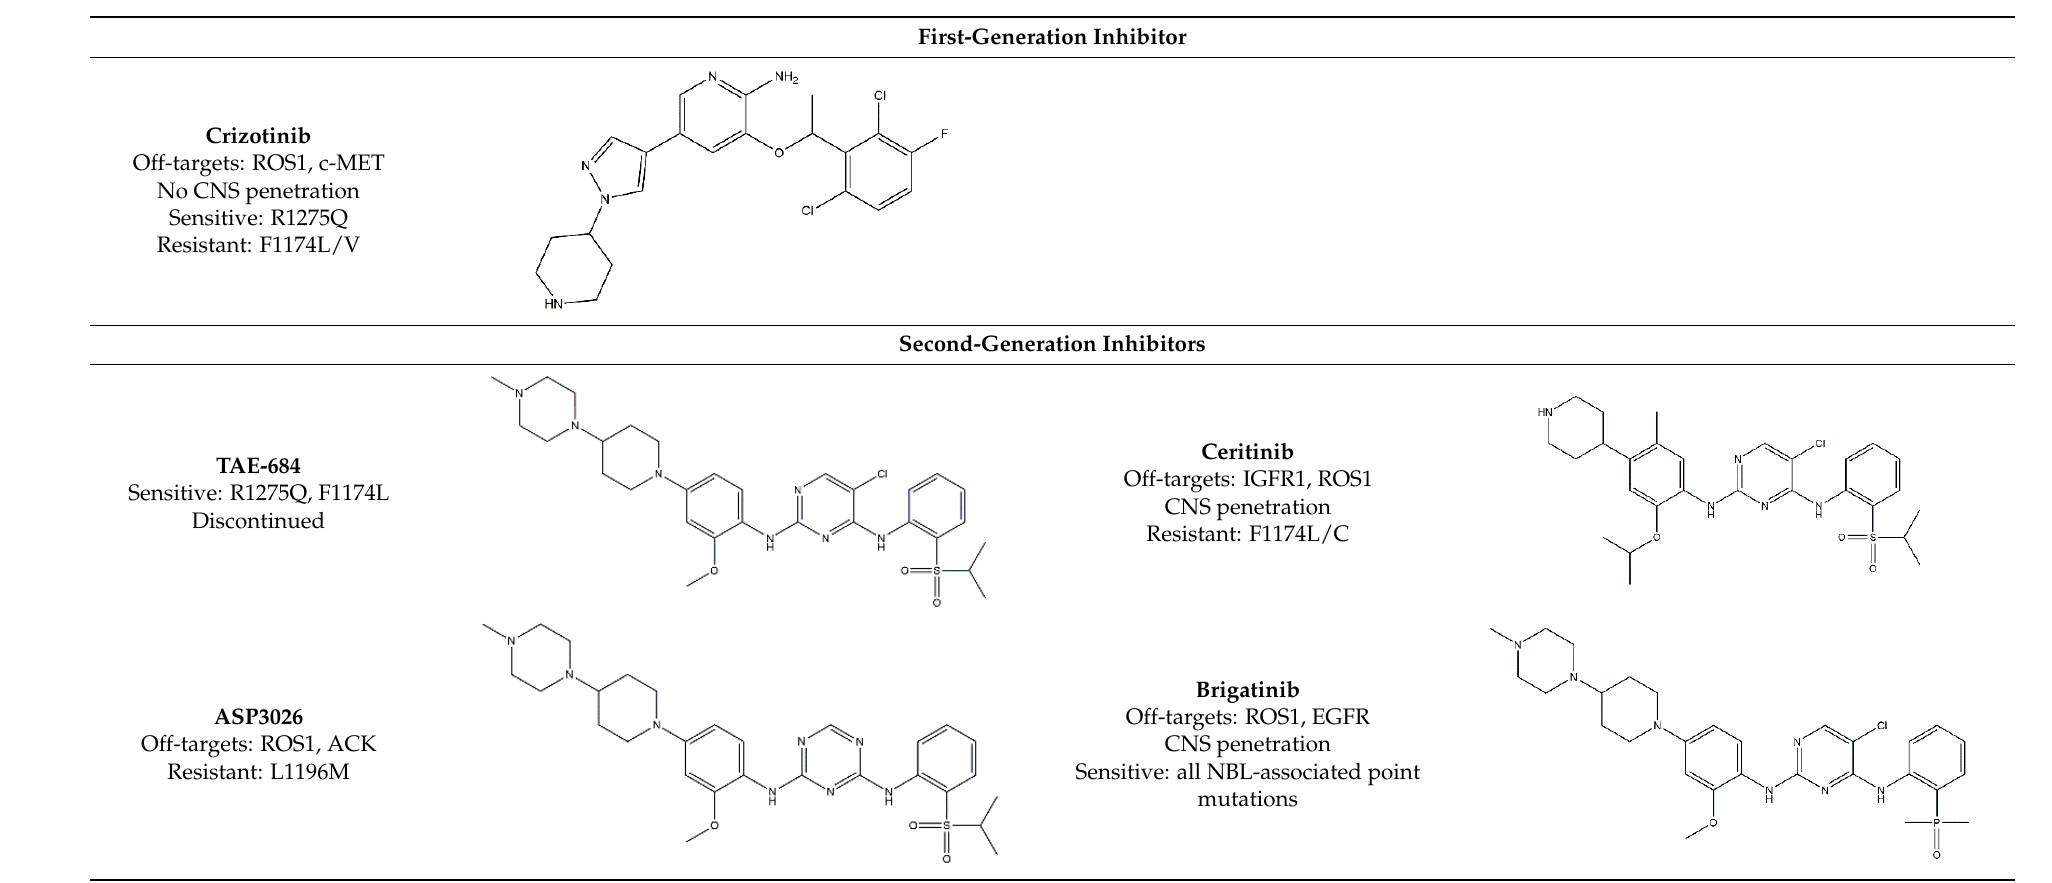
Table 2. Characteristics and structures of first-, second-, and third-generation of anaplastic lymphoma kinase inhibitors.